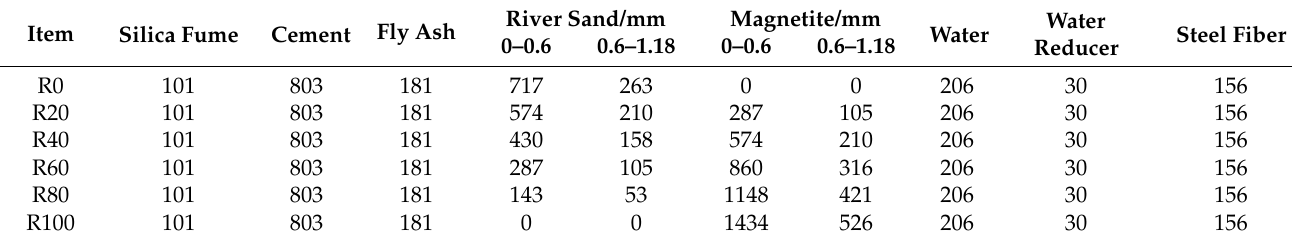
Table 3. Composition of MUHPC used in this study (kg/m 3 ).